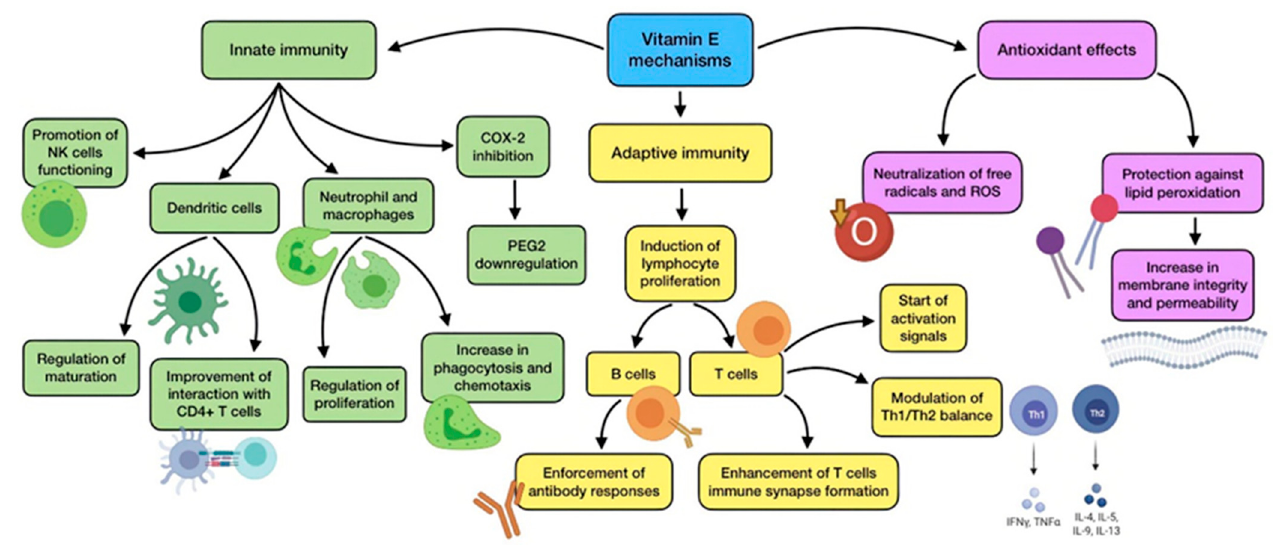
Figure 5. Summary of vitamin E main mechanisms of action.